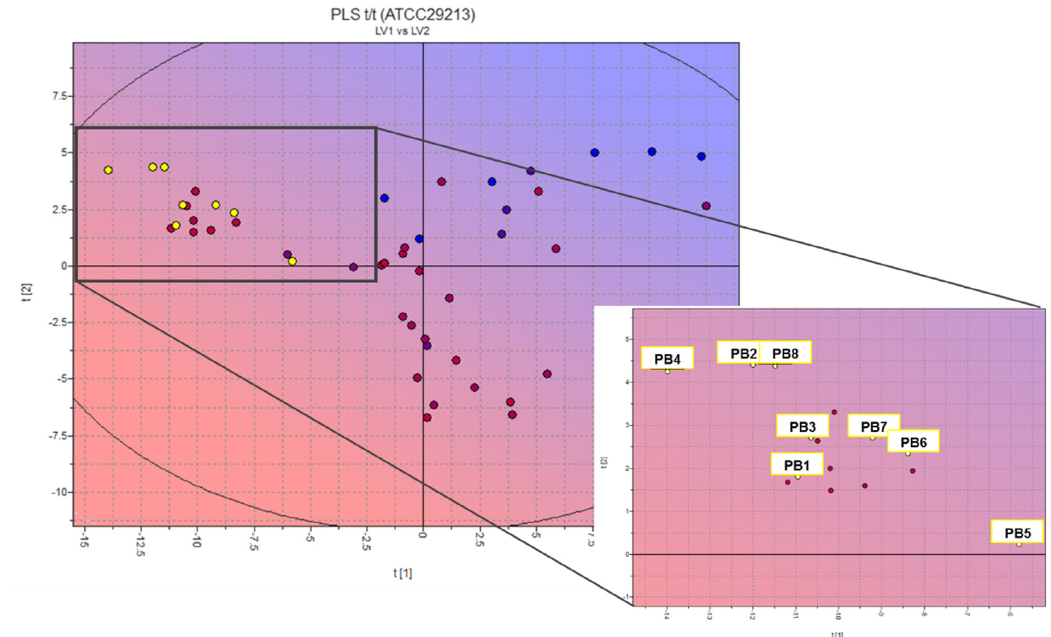
Figure 1. Two-dimensional scores plot of the PLS activity model at second latent variable and projection of designed compounds (inset: zoom on PBn projection). Color-scale by cytotoxic activity value: cyan/blue, low antimicrobial activity; pink/red, high antimicrobial activity; yellow circles: designed PBn compounds.